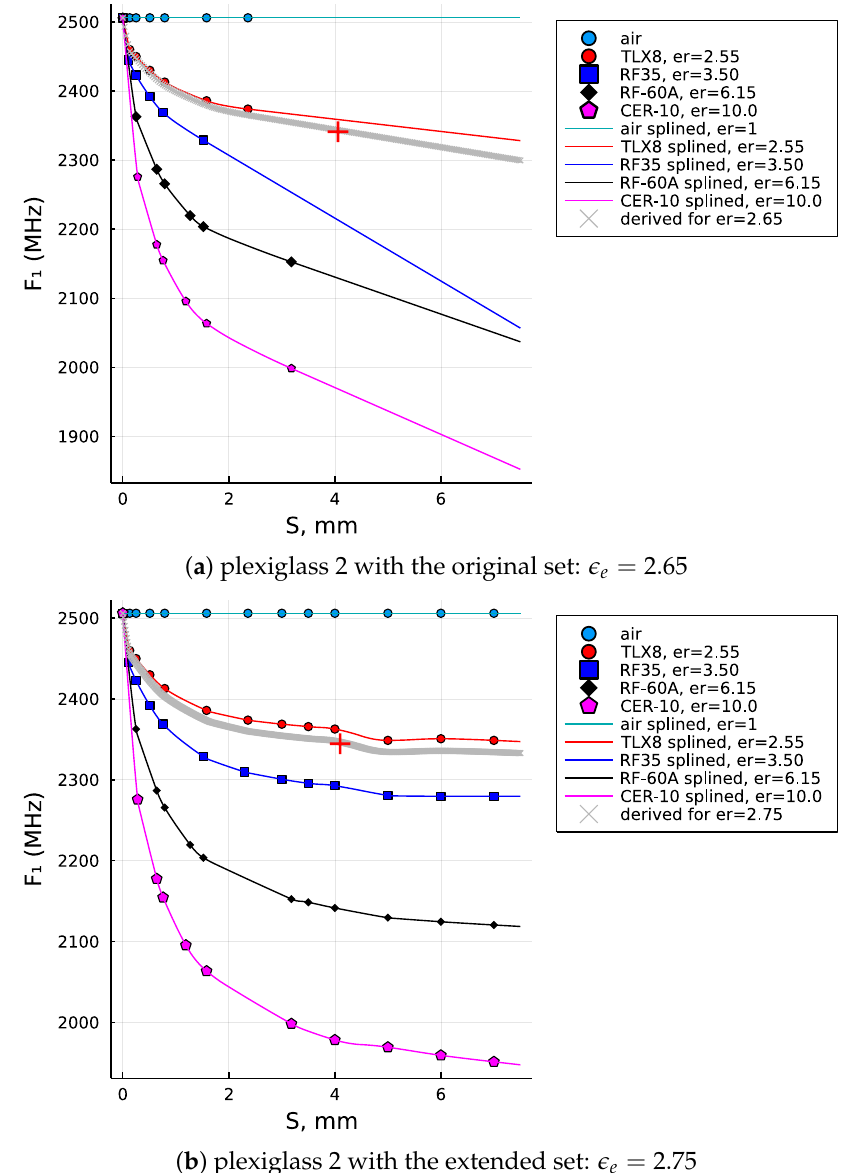
Figure 8. A comparison of the interpolation with the original reference data set ( S ≤ 3.18 mm) vs. the extended reference data set ( S ≤ 7.5 mm) and the solution for the plexiglass 2 sample with such settings. ( a ) the original reference data set. ( b ) the extended reference data